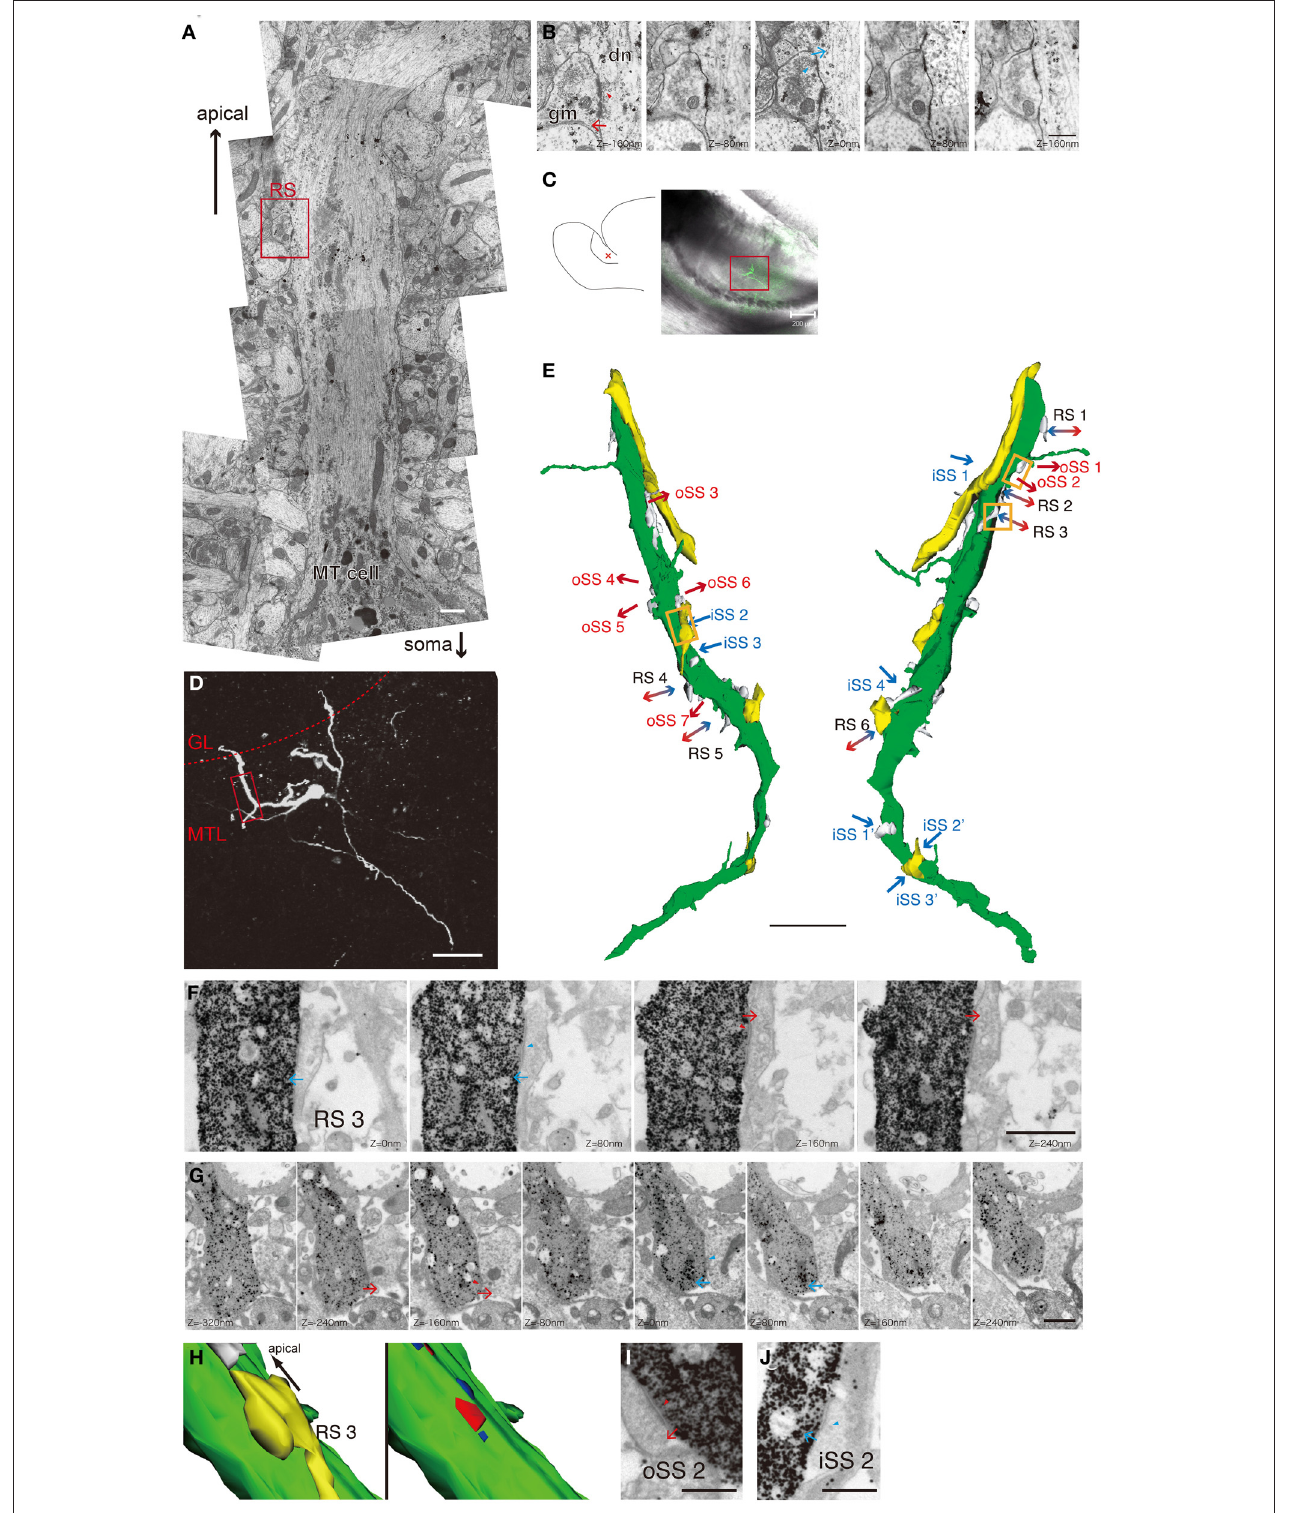
FIGURE 1 | Ultrastructual morphology and 3D images of MT cell primary dendrites in the AOB. (A) Basic morphology of the MT cell apical dendrite in vivo . The sample was fixed in general fixing solution for electron